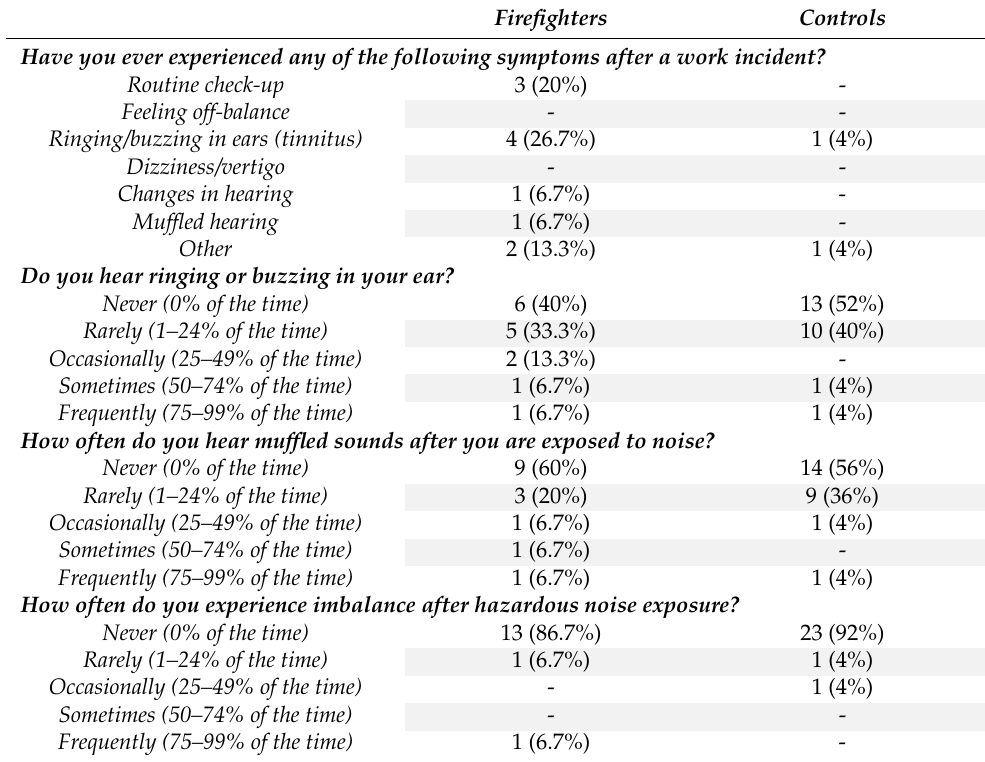
Table 2. Previous auditory and vestibular symptoms following noise exposure in firefighters and controls.